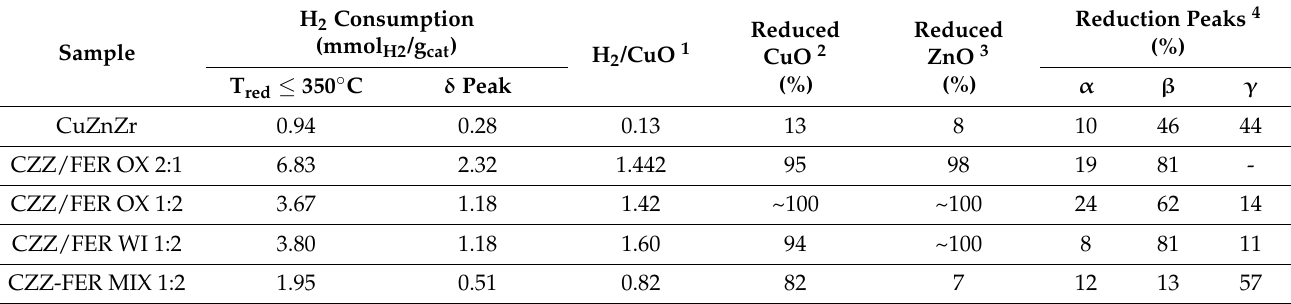
Table 1. Quantitative analysis of the H 2 -TPR